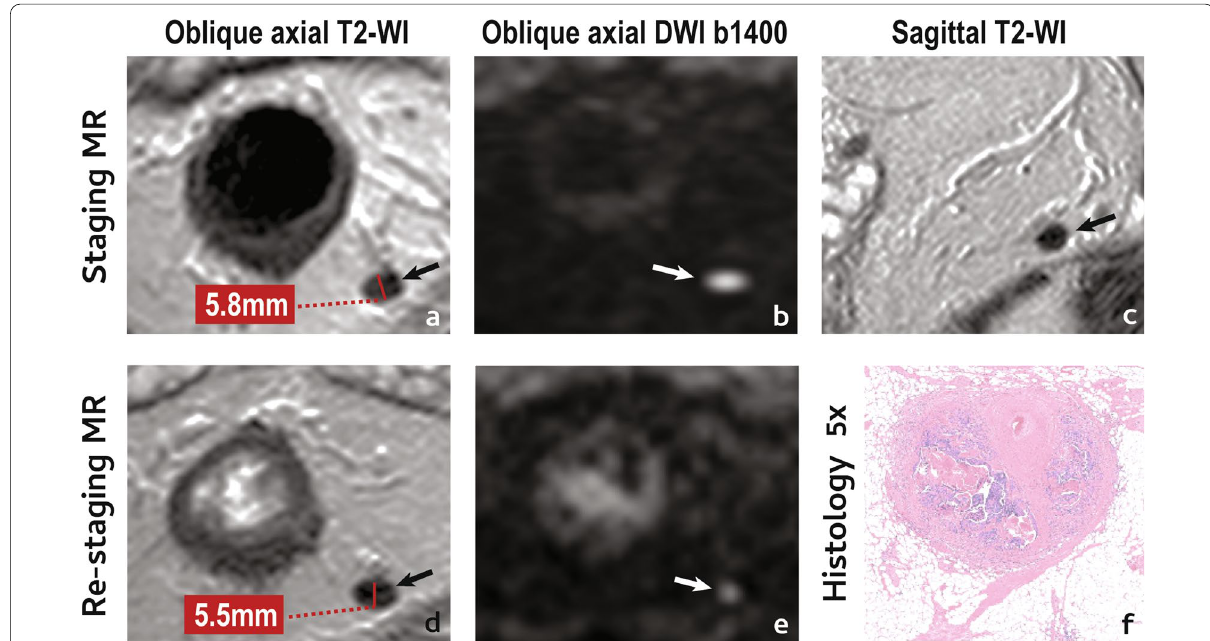
Fig. 4 Incomplete/poor lymph node response. A 65 year-old male presented with a low mrT3b (not shown) mrN1 (arrow in a – c ) EMVI CRM rectal cancer. He underwent NAT and was re-staged. Lymph node reduction in size was practically inexistent and post-NAT, short axis + was > 5 mm ( d ). On T2-WI, the lymph node still looked heterogeneous, with areas of intermediate signal intensity ( d ). High signal intensity on high b value images was less but still present ( e ) (please note that visibility on high b value post-NAT imaging does not exclude good or even complete response). Patient underwent surgery and no residual lymphoid tissue was found within the lymph node in the pathology specimen, only tumour surrounded by fibrosis, adjacent to a vessel ( f )—patient was therefore staged as a ypT3 N1c TRG3 R0